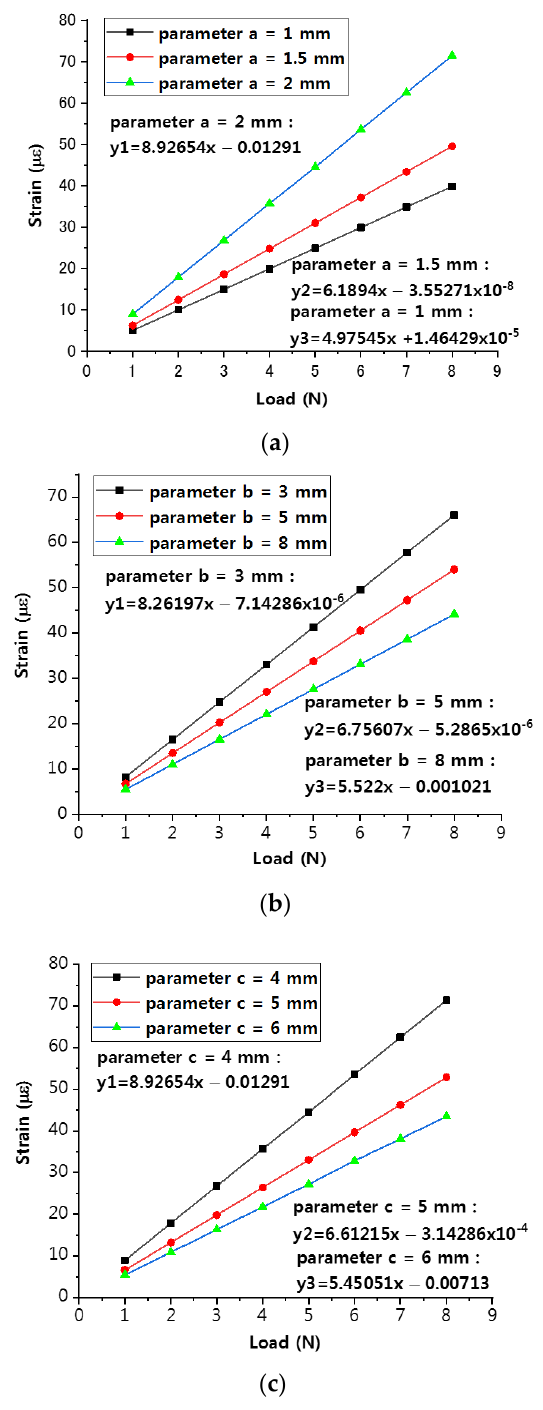
Figure 7. Influence curve of the different parameters in the amplification area. ( a ) Influence of parameter ‘a’ to strain ; ( b ) influence of parameter ‘b’ to strain ; ( c ) influence of parameter ‘c’ to strain . The simulation data are shown in Table 2. Table 2. The data of parameters a, b and c under different loads.